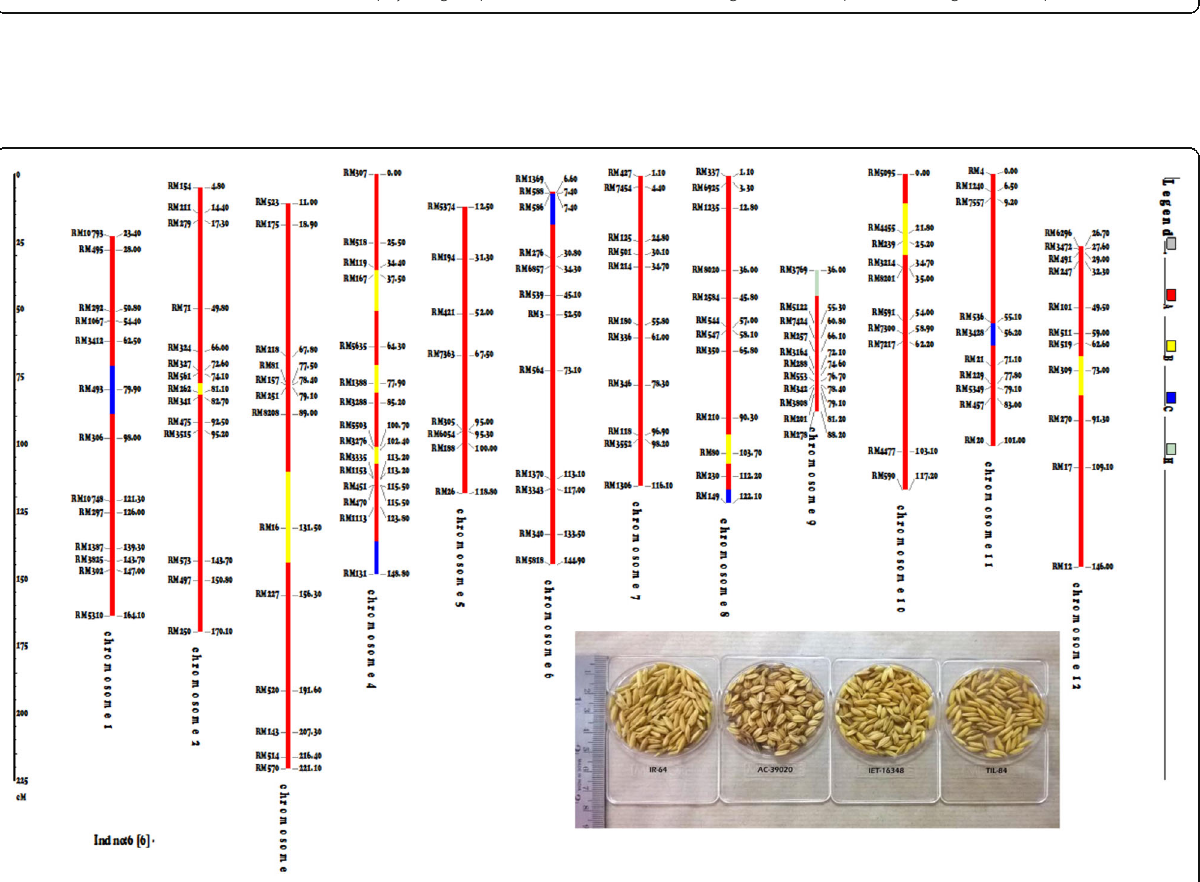
Fig. 3 Comparison of selected trait introgressed lines with IR-64 for RWC, Δ 13 C, TLA, spikelet fertility and grain yield under managed drought environment. *, ** indicates a significant difference at P =0.05, 0.01. Note: Selected five TILs along with the IR-64 were grown under well watered (100% FC) and water limited (60% FC) conditions under MDE. Various physiological parameters were measured at vegetative and reproductive stage and compared with IR-64